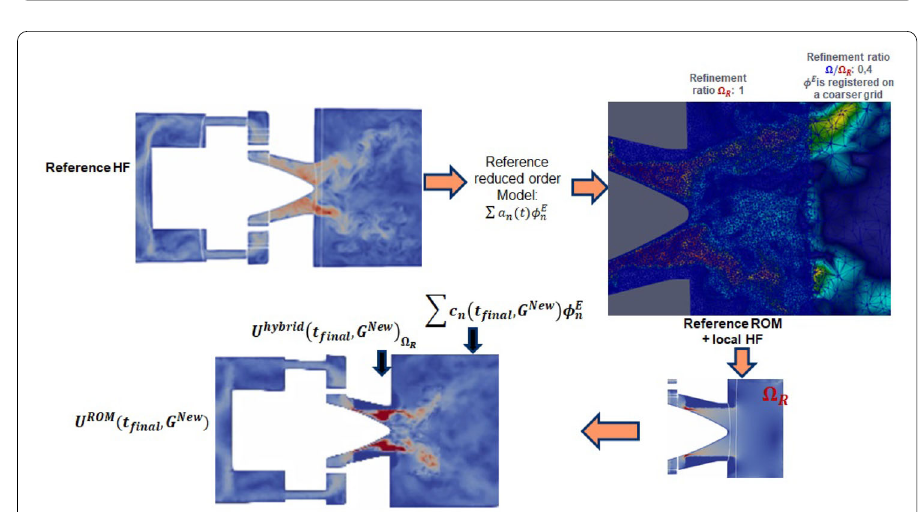
Fig. 38 A schematic representation of the UGPOD: this flowchart shows the final time step obtained by the UGPOD for configuration 1